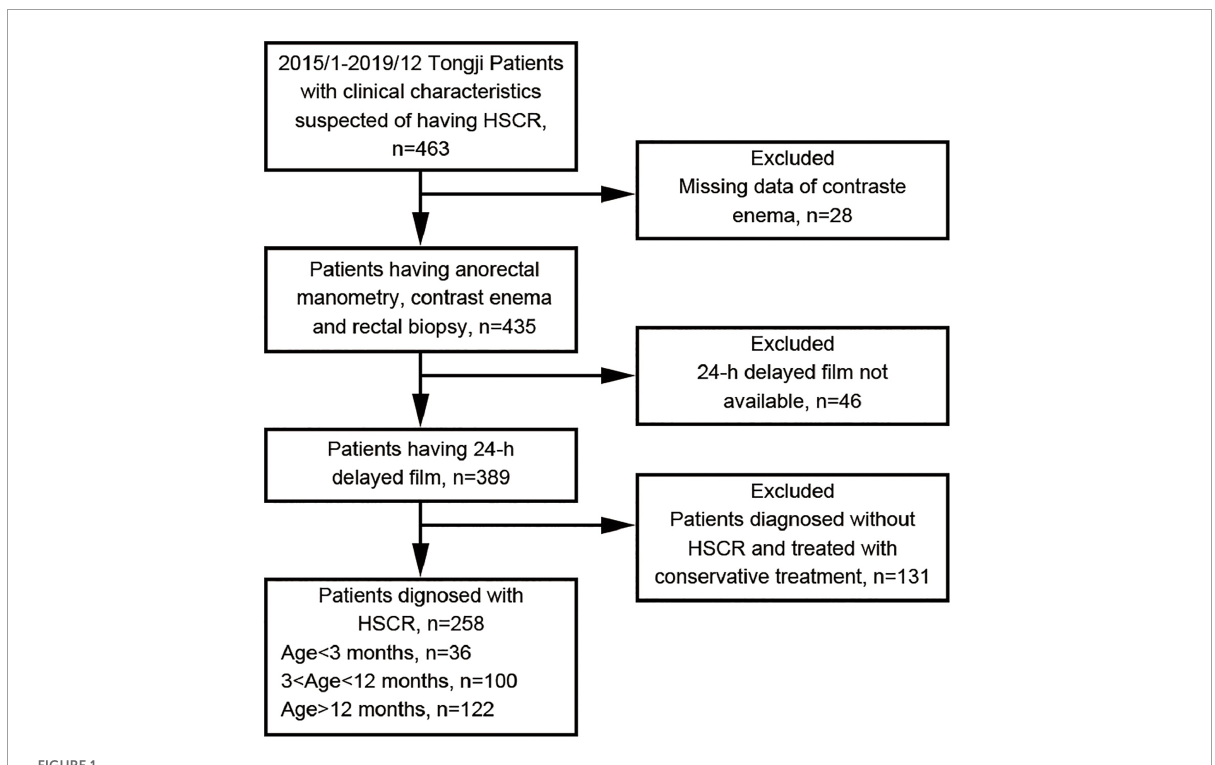
FIGURE1 Flow chart of the study